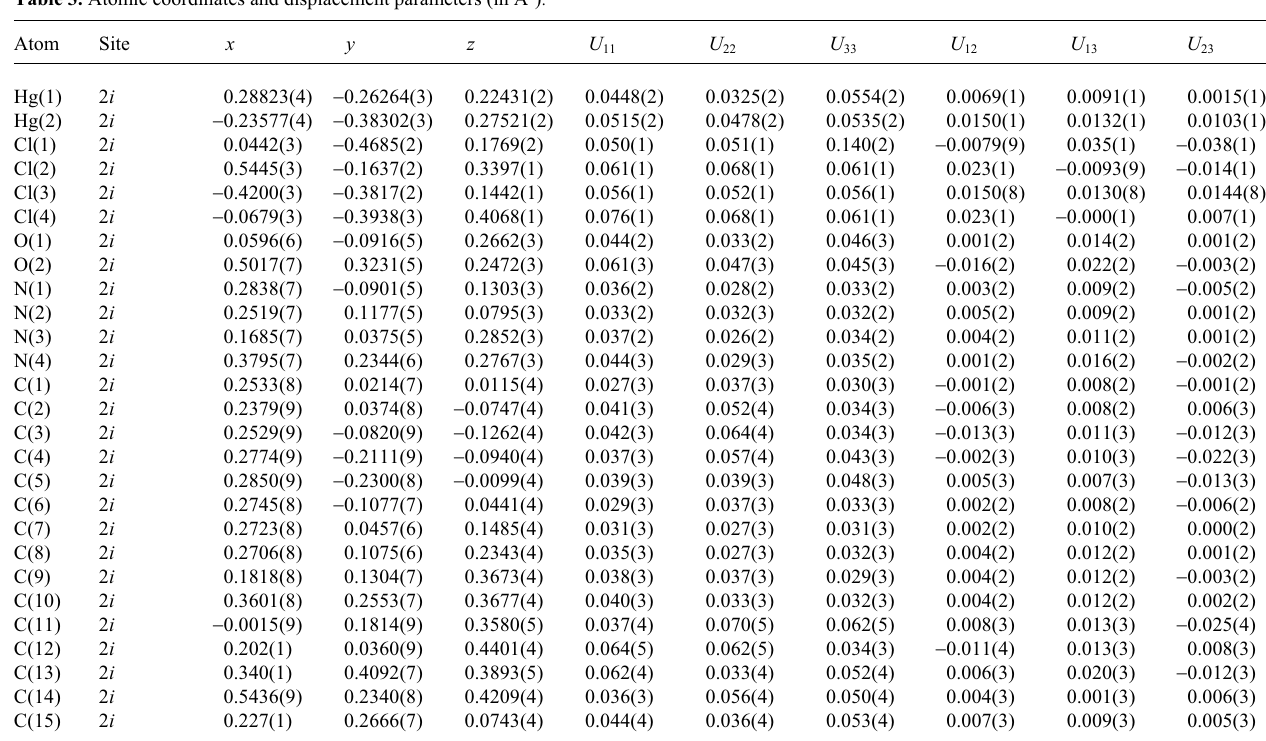
Table 3. Atomic coordinates and displacement parameters (in Å 2 )